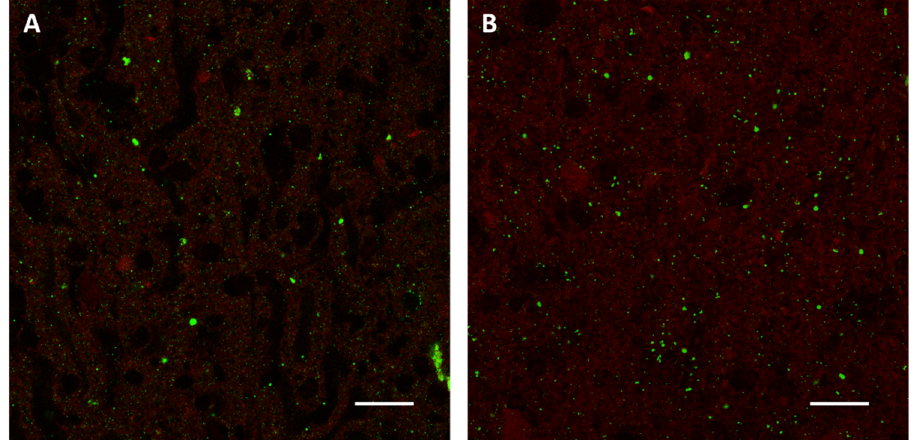
Figure 2. Direct Fluorescent Antibody test performed on samples prepared using the standard in vivo method ( A ) and an alternative in vitro method based on infected BSR and Neuro-2a cells ( B ). An anti-rabies nucleocapsid conjugate (Biorad) was used for the detection of rabies virus antigens (green). Images were acquired by Leica SP8 confocal microscope (63× objective, 25 µm bar).